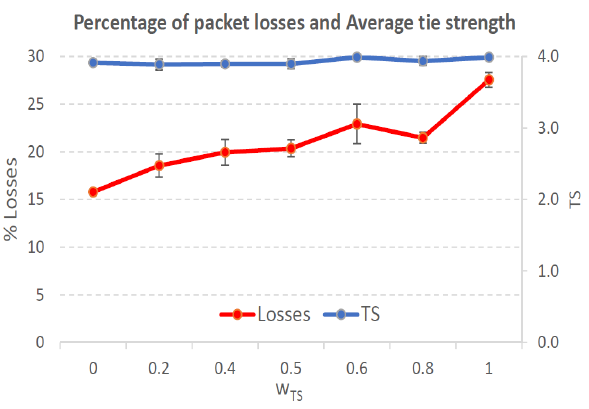
Figure 18. Percentage of packet losses and average tie strength of the forwarding path. Scenario with very high social media interaction (TS normal distribution with µ = 4 and σ = 1). Nodes’ density = 200 nodes/km 2